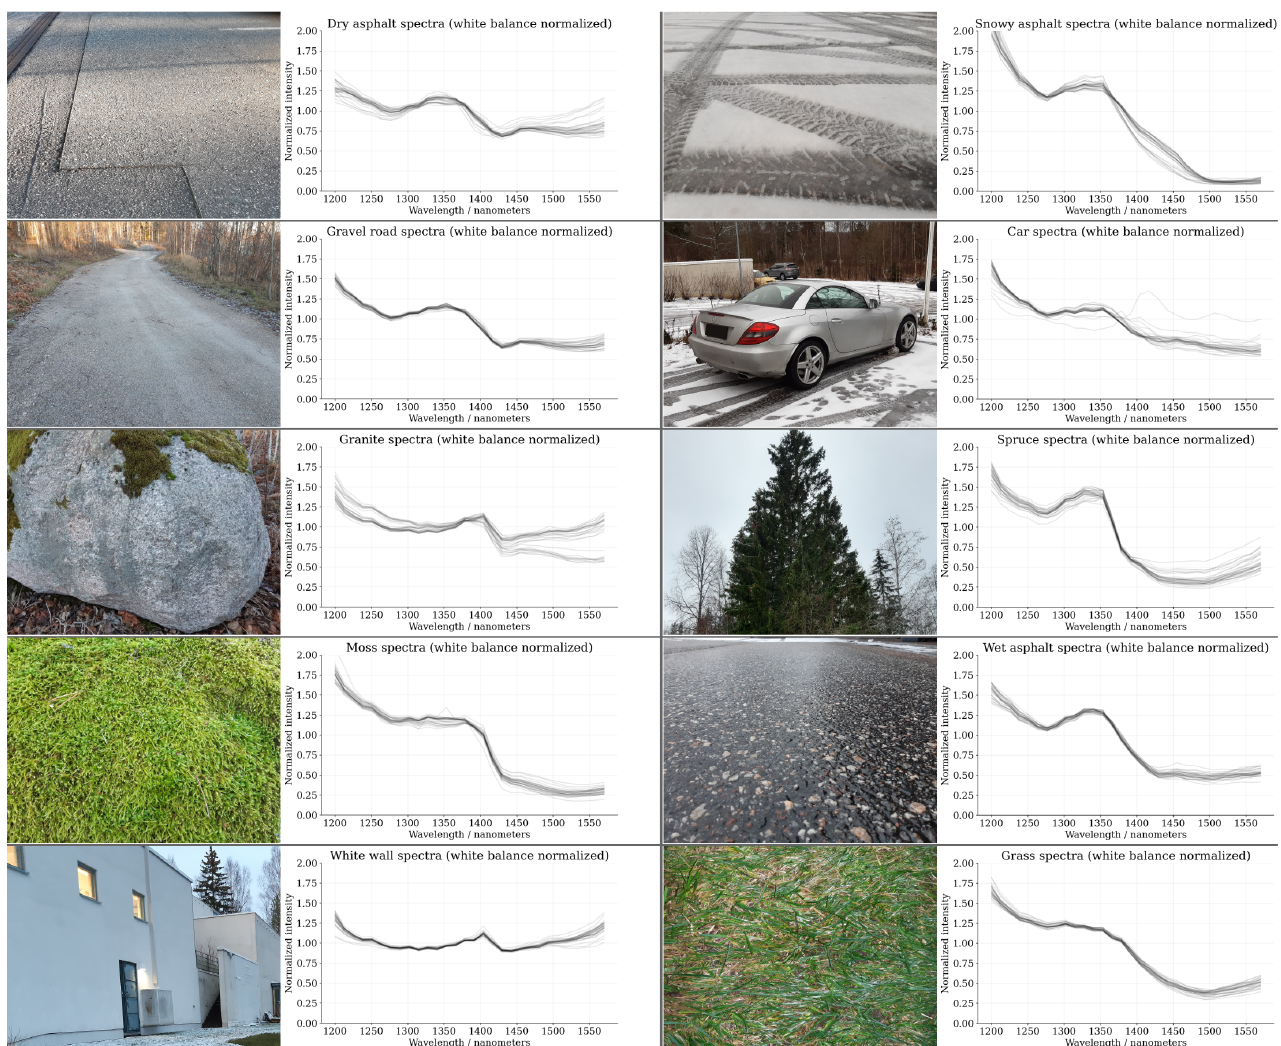
Figure 7. Examples of the dataset classes and their respective relative spectral reflectance curves (each curve represents one of the class specific measurements from a total of 30 per class). The spectral curves have been averaged over the full measurement sequence of 10,000 frames ( N frames = 10,000). The dataset consists of 10 classes with 30 samples in each class (300 samples in total). Each sample has been acquired as a static spot measurement (no beam steering) by recording 10,000 consecutive frames ( ≈ 1 µ s exposure time per frame) from the SPAD array (0.33 s acquisition time per sample at 30 kHz laser pulse repetition